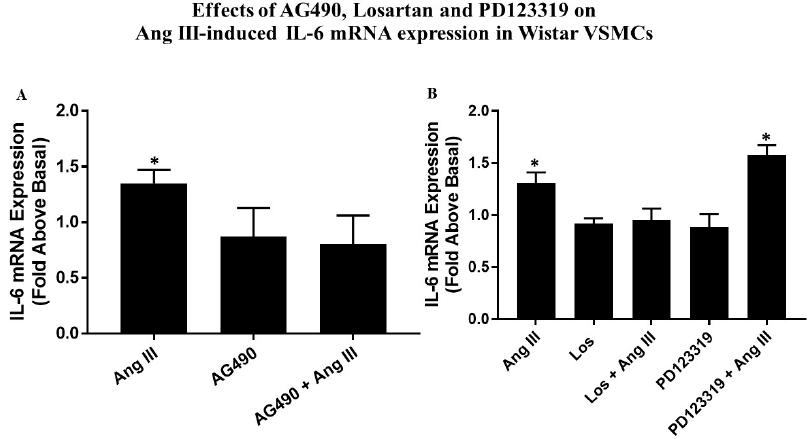
Figure 7. Effects of AG490, Losartan, PD123319 on Ang III-induced IL-6 mRNA expression in Wistar VSMCs. Quiescent Wistar VSMCs were pretreated with either 50 µM AG490 ( A ) or 10 µM Losartan (Los) or 10 µM PD123319 ( B ) for 15 min. Subsequently, the cells were treated with or without 100 nM Ang III for 3 h. IL-6 mRNA expression was analyzed by quantitative PCR. The vehicle for AG490 was DMSO; incubation with Ang III was also done in the presence of DMSO. Each value represents the mean ± SEM of preparations of VSMCs isolated from four or more Wistar rats. * Denotes p < 0.05 as compared to basal levels of IL-6 mRNA expression from VSMCs isolated from Wistar rats.